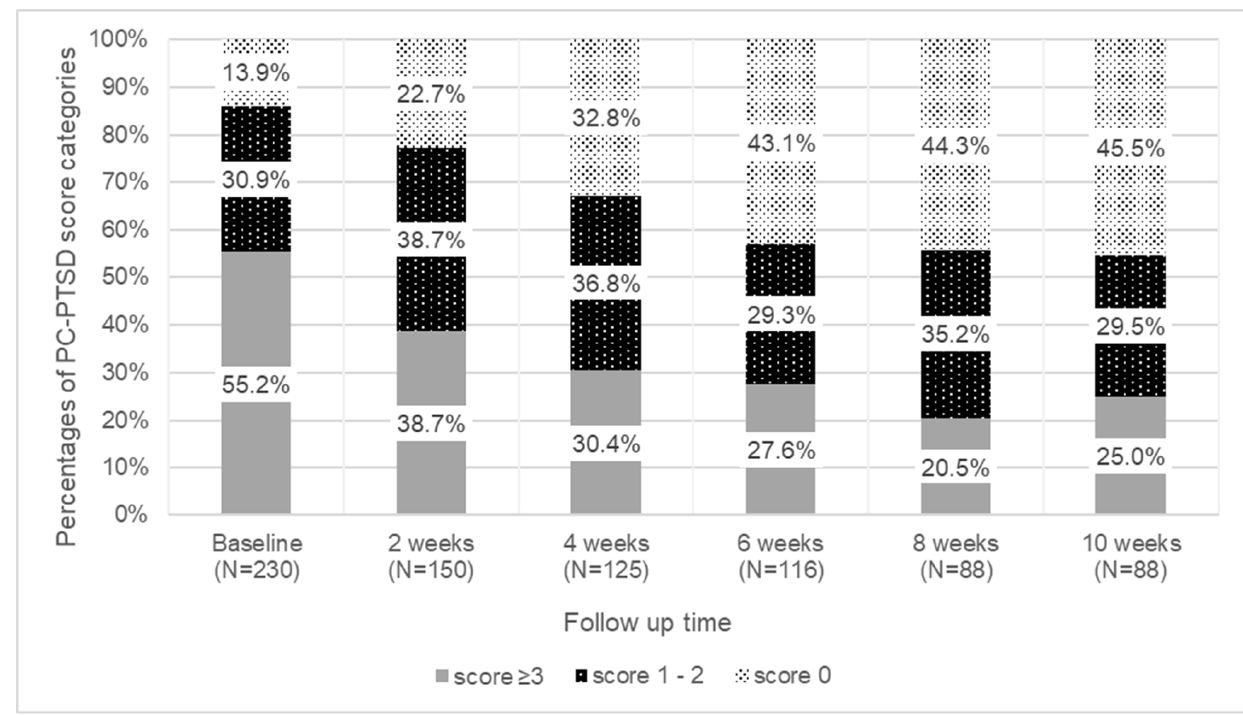
Figure 1. Proportion of participants with PC-PTSD scores of 0, 1–2, and ≥ 3 across the 10-week follow-up period.